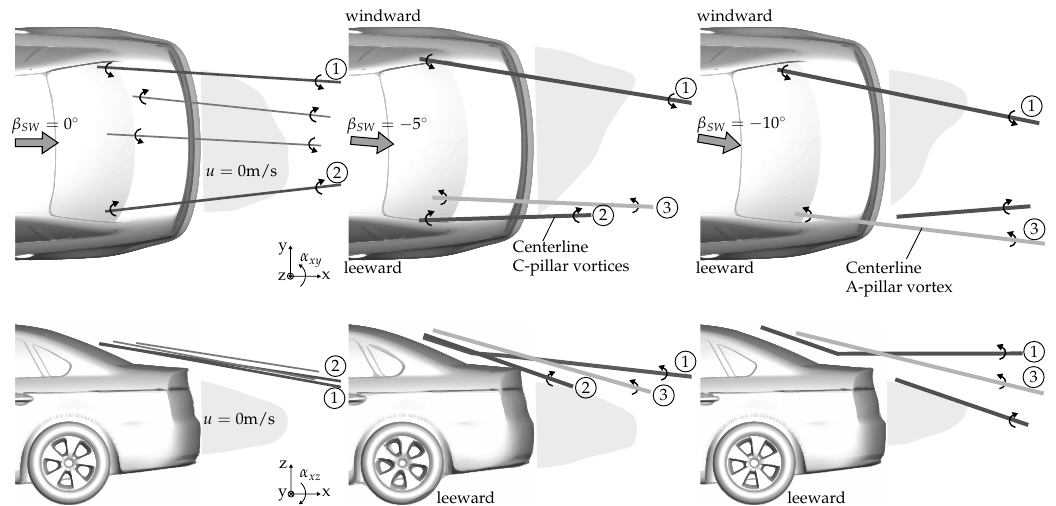
Figure 11. Centerlines of the vortex cores and the size of the recirculation area in the upper part of the model at changing side wind directions.